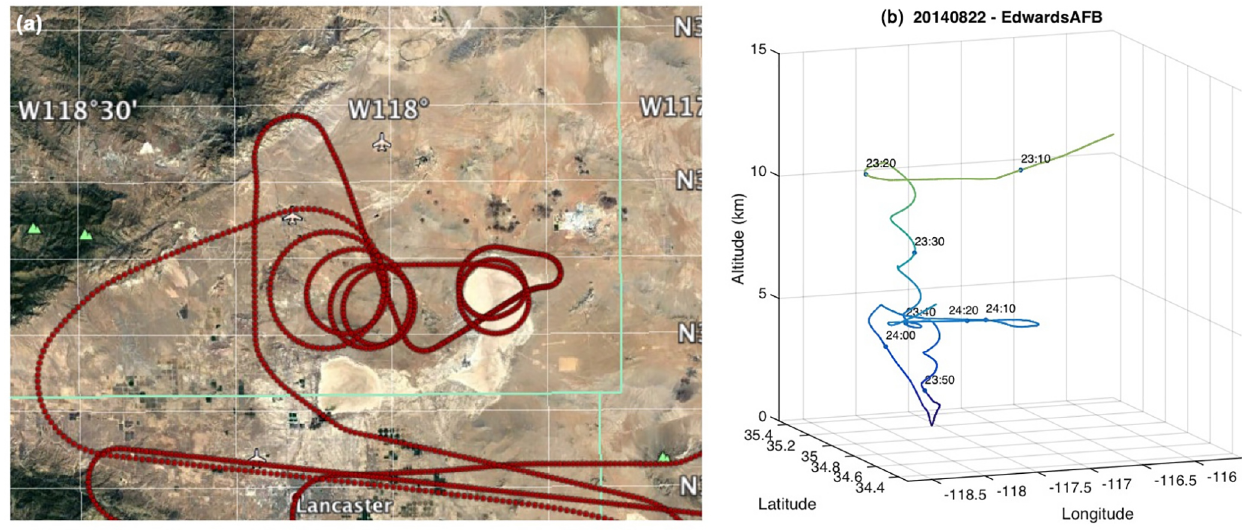
Figure 13. (a) Map of the track of the spiral down over Edwards AFB, California, on 2014 SF2 on 22 August 2014. (b) Time-tagged location and altitude plot for that flight